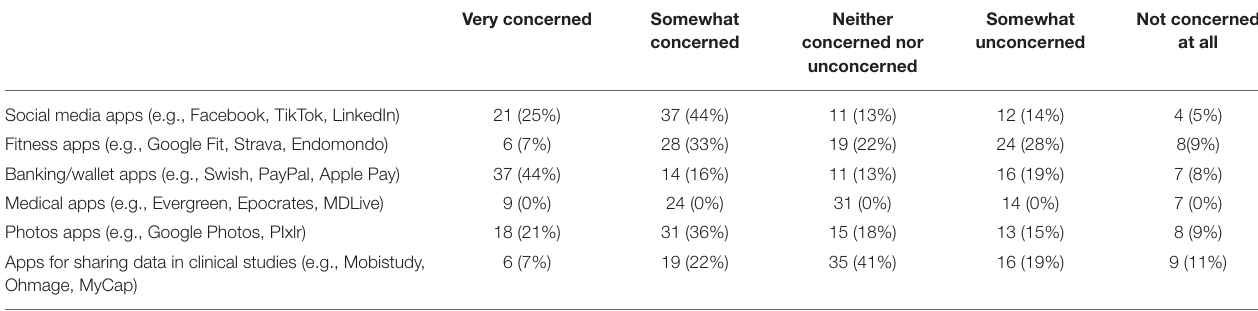
TABLE 6 | Answers to the question “How concerned are you about privacy when it comes to the following types of apps?” ( n = 85). Very concerned